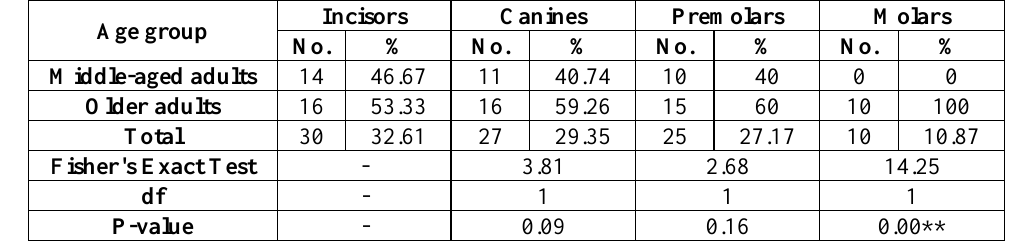
Table 3: Frequency distribution of tooth wear scores according to segment type by age group Age group Middle-aged adults